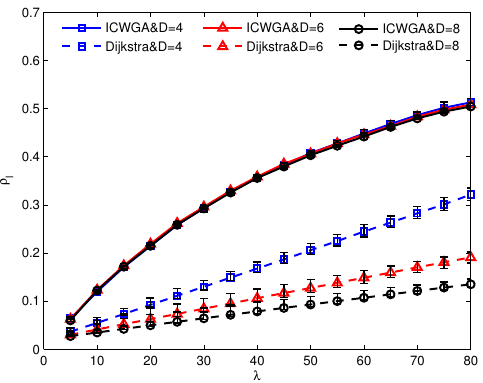
Figure 8. Average bandwidth utilization of different link